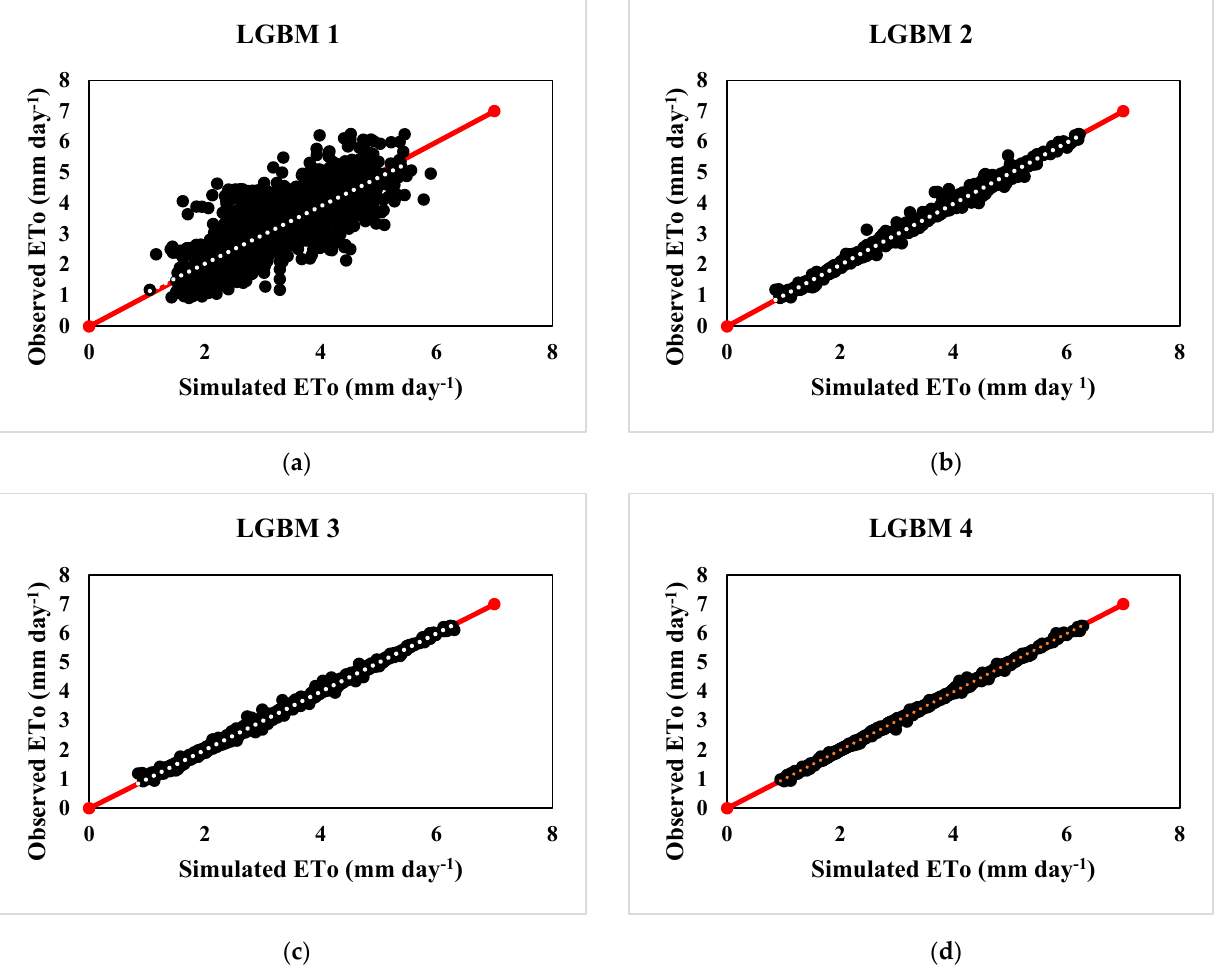
Figure 4. Comparison of the daily observed and simulated ET 0 by LGBM model; ( a ) LGBM 1; ( b ) LGBM 2; ( c ) LGBM 3; ( d ) LGBM 4. (Cameron Highlands station).